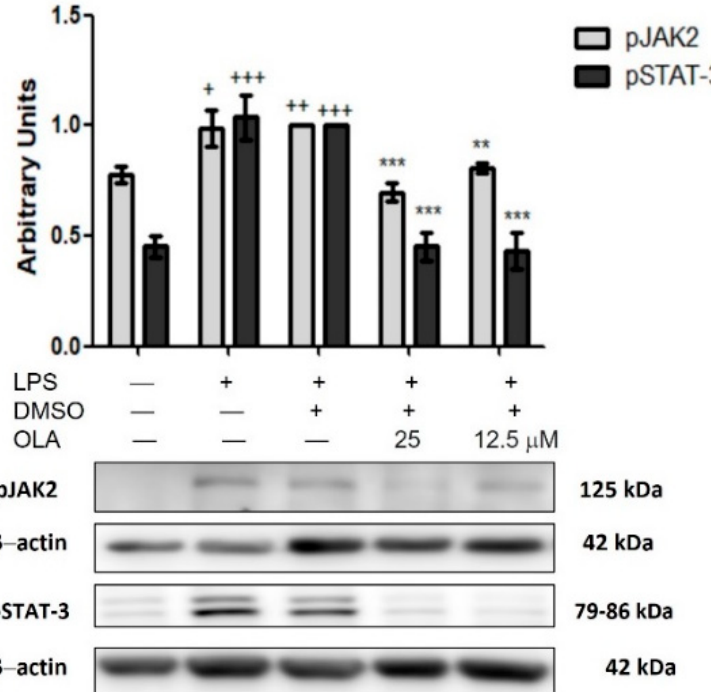
Figure 7. OLA treatment modulated JAK/STAT signaling pathway in LPS-stimulated murine peri- toneal macrophages. Cells were untreated or treated with OLA (25 and 12.5 µ M) for 18 h in presence or absence of LPS. Data shown are means ± SEM ( n = 6). + p < 0.05, ++ p < 0.01, +++ p < 0.001 vs. control cells (no stimulated); ** p < 0.01, *** p < 0.001 vs. LPS − DMSO-treated cells.